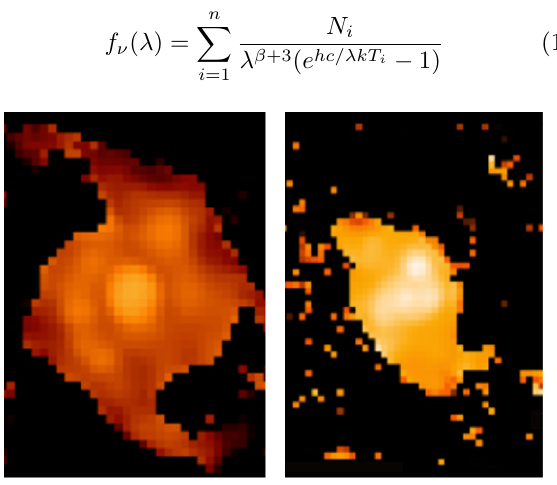
Figure 1: Temperature maps of NGC 1365 (left) and NGC 1566 (right). Average temperatures range from ∼ 17–18K in the inter-arm regions to T ∼ 23–24K in the bright spots within the spiral arms. The highest average dust temperatures are ob- served in the central region of NGC 1365 with T ∼